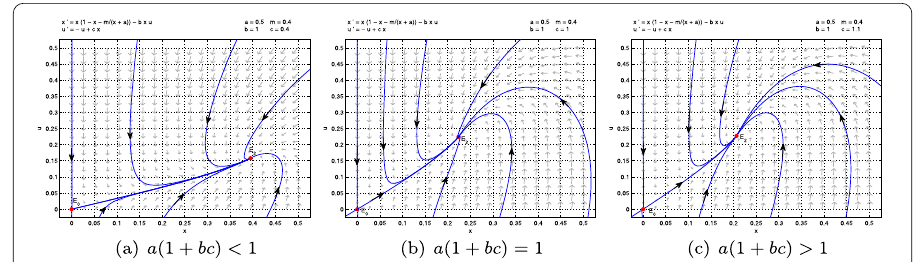
Figure 2 The phase portraits of system (1.6) when m > a : ( a ) Two distinct positive equilibria E 1 and E 2 . E 1 is a saddle and E 2 is locally asymptotically stable. ( b ) Unique positive equilibrium E 3 which is a saddle-node. ( c ), ( d ), ( e ) No positive equilibria